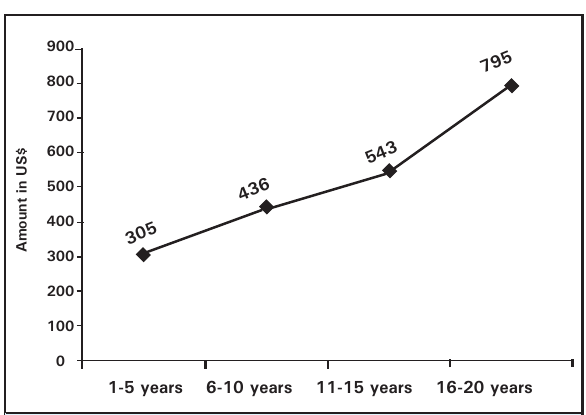
Figure 1. Mean value of total direct cost per annum (in US$) among respondents with the respec ti ve dura ti on of